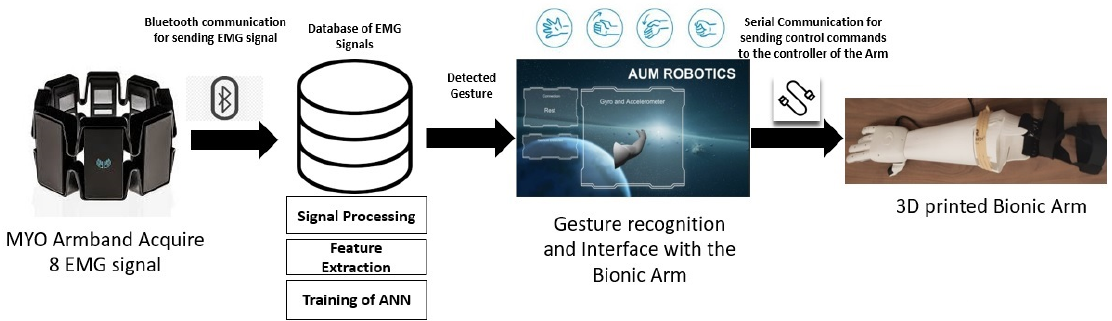
Figure 2. Schematic chart to control the bionic